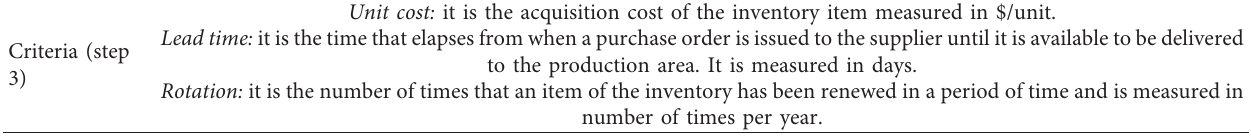
Table 8: Application of step 3 of the methodology (identification of criteria).